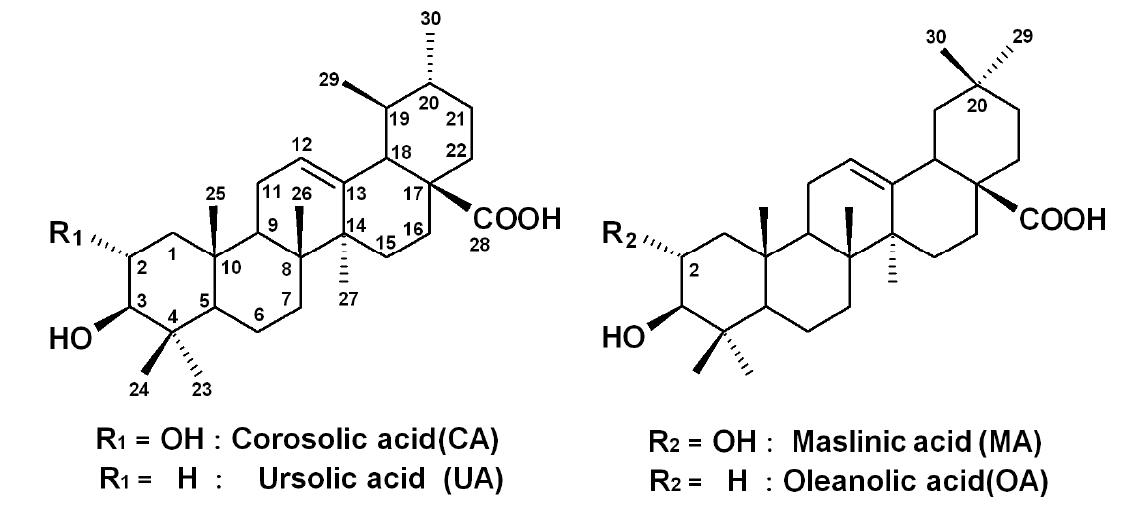
Figure 1. Chemical structures of corosolic acid (CA) and ursolic acid (UA), maslinic acid (MA) and oleanolic acid